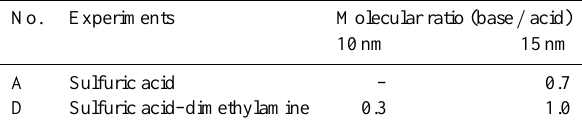
Table 2. Molecular ratio of base to acid compounds from the E- AIM model, assuming no evaporation of dimethylamine from the particles. The E-AIM results were derived from the HGF results of particles. Based on TDCIMS measurements, we assumed that the acid compound is only sulfuric acid and that base compounds consist of 50% ammonia and 50% dimethylamine in the